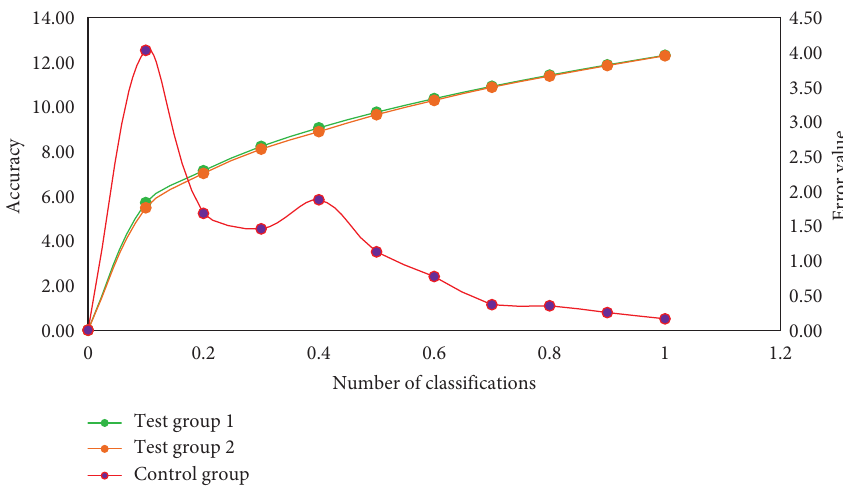
Figure 9: Preliminary results of the Table 2: Preliminary evaluation results of experiments.